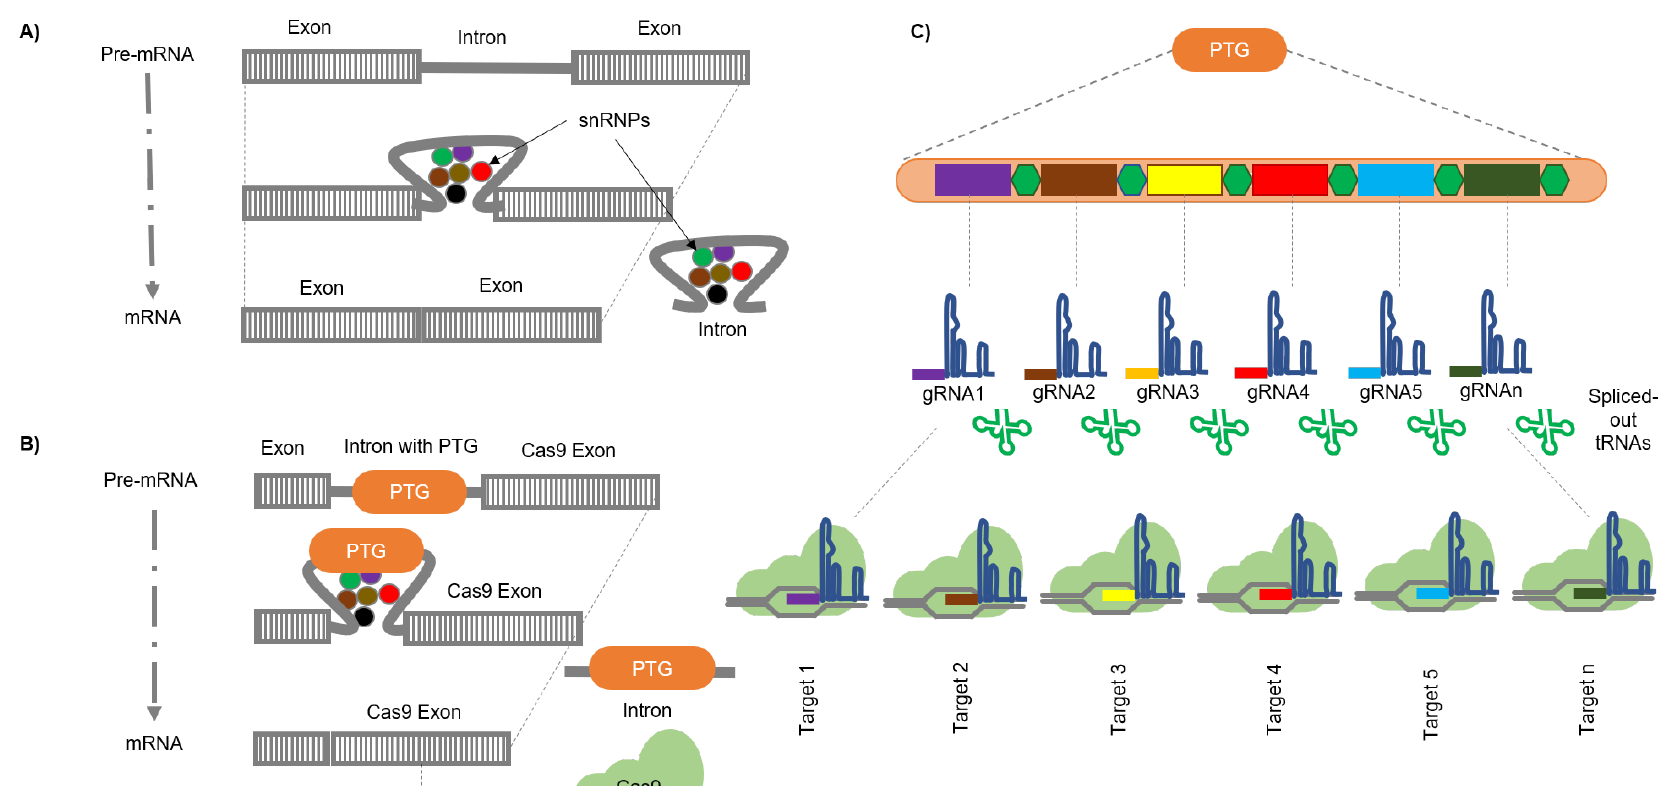
Figure 4. Schematic representation of multiplex genome editing by utilizing intron polycistronic transfer RNA-guide RNAs (inPTGs). Here, figure ( A ) depicts the regular small nuclear ribonucleoprotein (snRNP) mediated splicing mechanism. ( B ) Introns are engineered to code for fused polycistronic tRNA-gRNAs (PTGs). ( C ) PTGs are further processed to release individual gRNAs (shown here in different colors) via the tRNA processing machinery. Individual gRNAs can then go on to target their complementary loci in the genome.